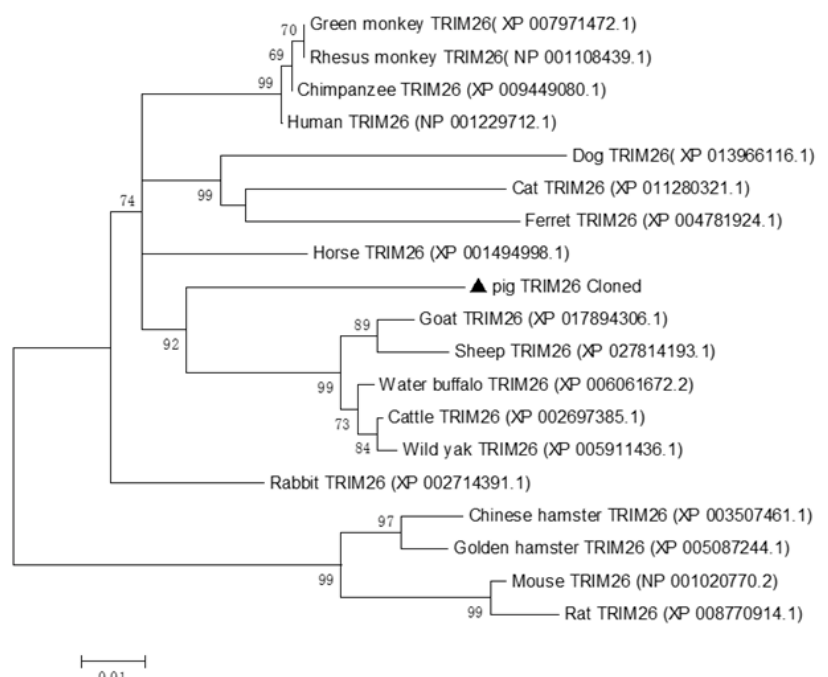
Figure 1. Multiple alignment and phylogenetic analysis of TRIM26. ( A ) Polypeptide of porcine TRIM26 was aligned with that of human, mouse, and rat. The RING finger domain (RING), the B-box domains (B-box), and the coiled-coil region (CC) are labeled in reference to the human TRIM26. The antigenic peptide is shown in the red box. ( B ) The phylogenetic tree of TRIM26, constructed by neighbor-joining method using MEGA 6.06.